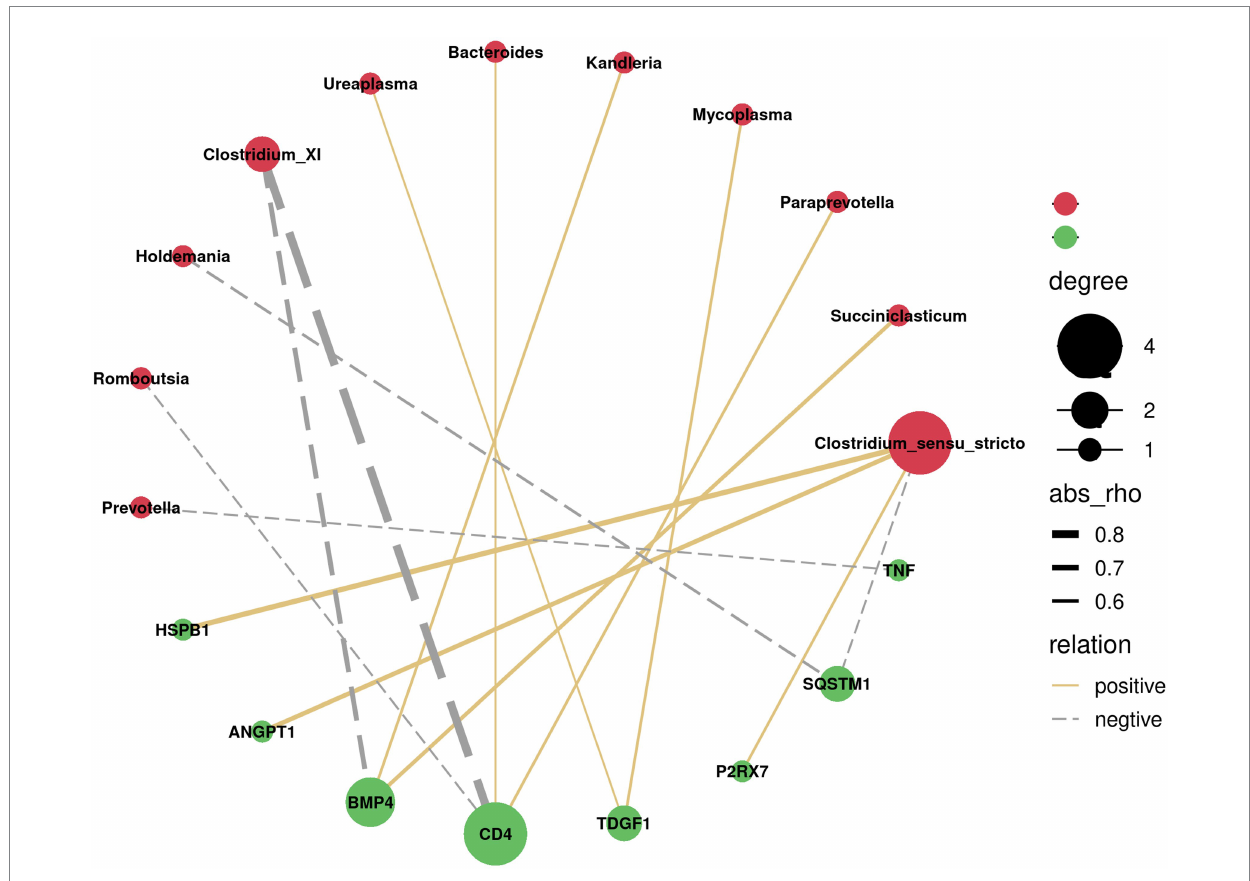
FIGURE 5 Correlation network analysis between the core genes (green circles) of positive regulation of MAPK cascade and regulation of I-kappaB kinase/NF- kappaB signalling and the predominant bacteria at genus level (red circles) in the ileum. Silver lines, negative correlation ( p < 0.05); Golden lines, positive correlation ( p <